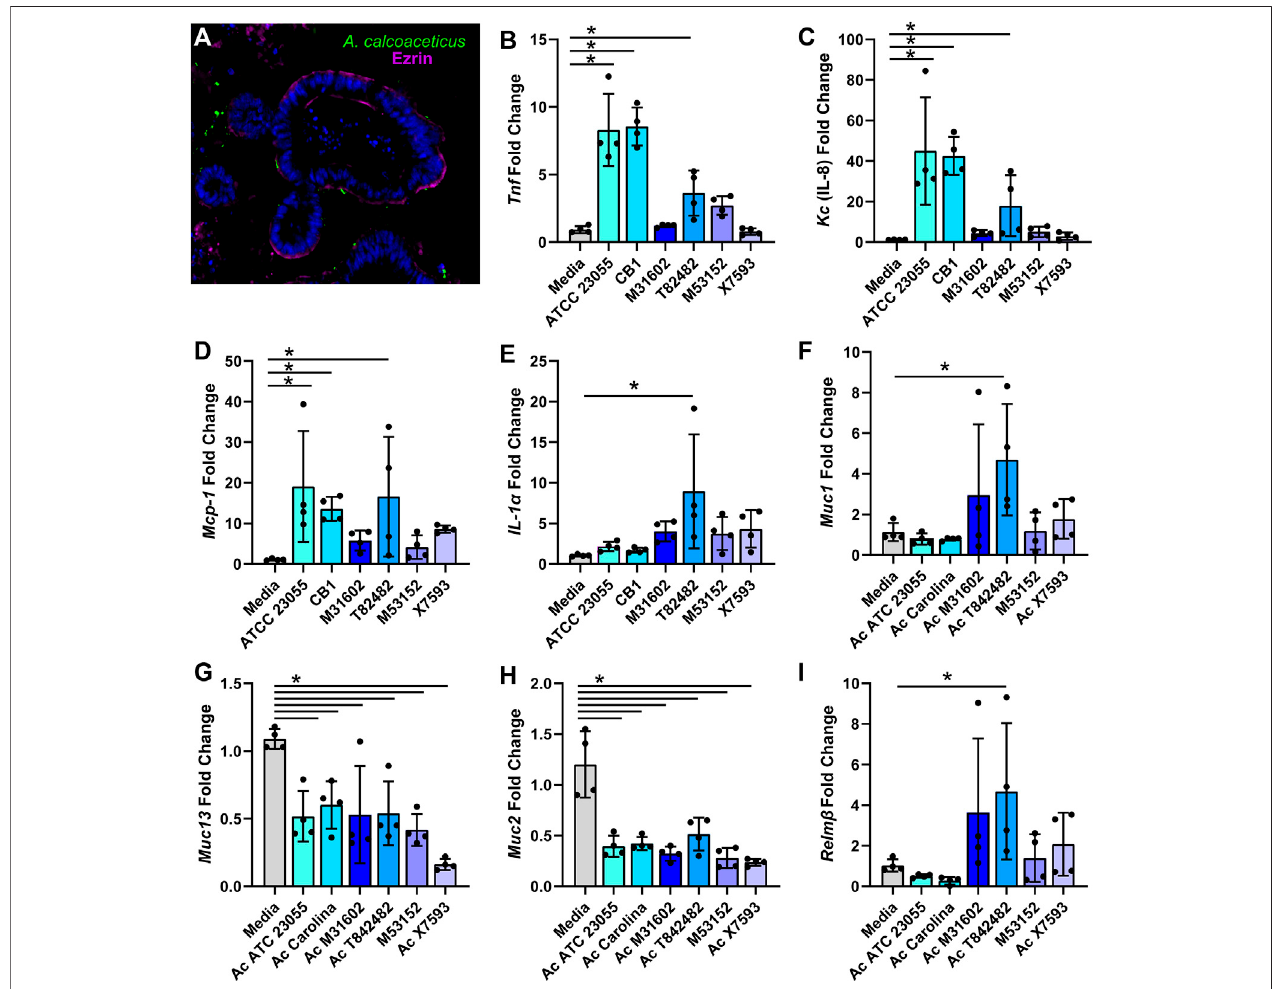
FIGURE 7 | (A) calcoaceticus induces in fl ammatory responses in intestinal organoids. (A) Inside-out organoids incubated with live fl uorescently tagged A. calcoaceticus and immunostained with the apical marker phospho-Ezrin. qPCR analysis of organoids after 3 h of incubation examining expression of (B) Tnf , (C) IL-18 , (D) Mcp-1 , (E) IL-1alpha , and (F) Muc1 , (G) Muc13 , (H) Muc2 , and (I) Relm β